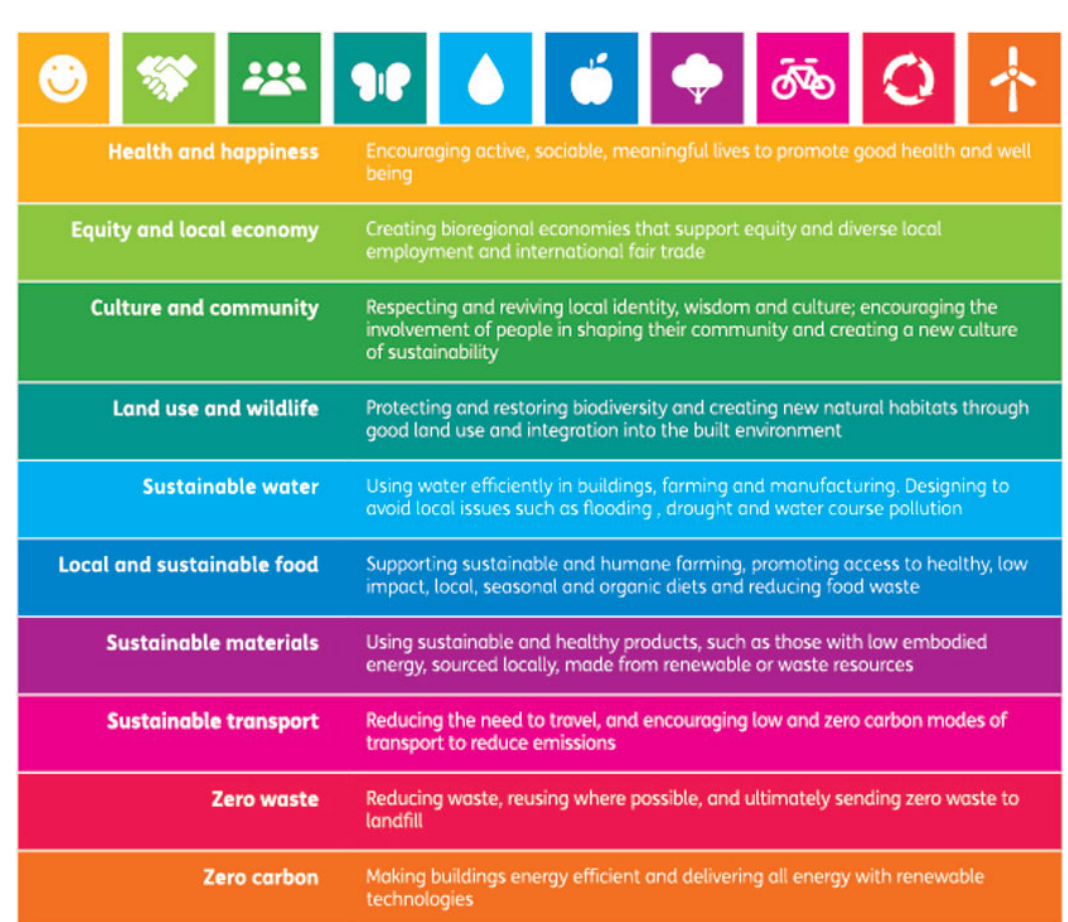
Figure 3. The OPL Goals. Source: Bioregional (n.d.). et al. (2016) through specific performance targets, post- planning evaluation while taking a holistic approach to sustainable urban